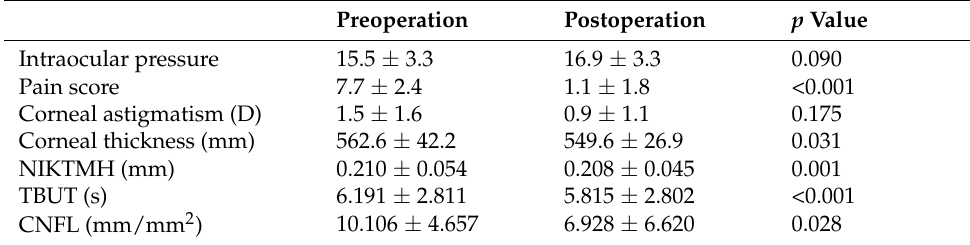
Table 2. Major postoperative outcome